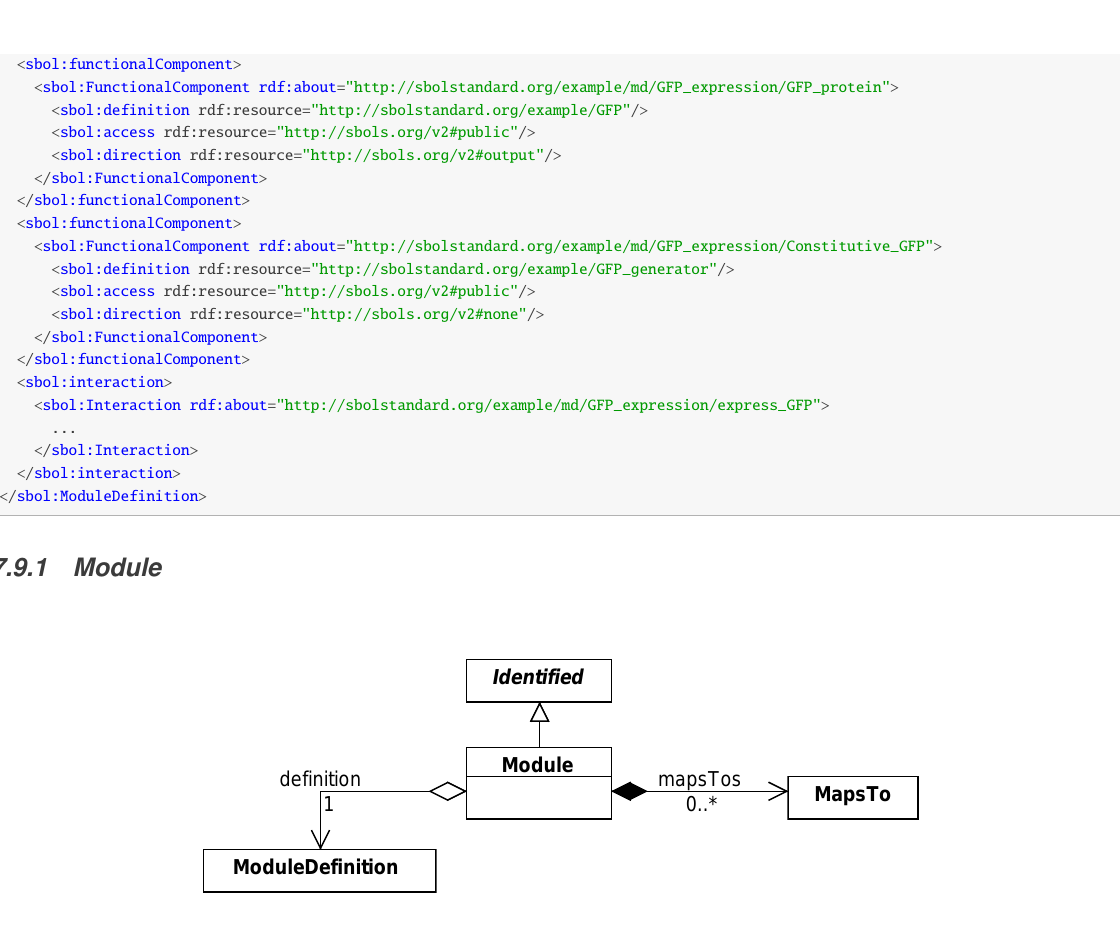
Figure 16: Diagram of the Module class and its associated